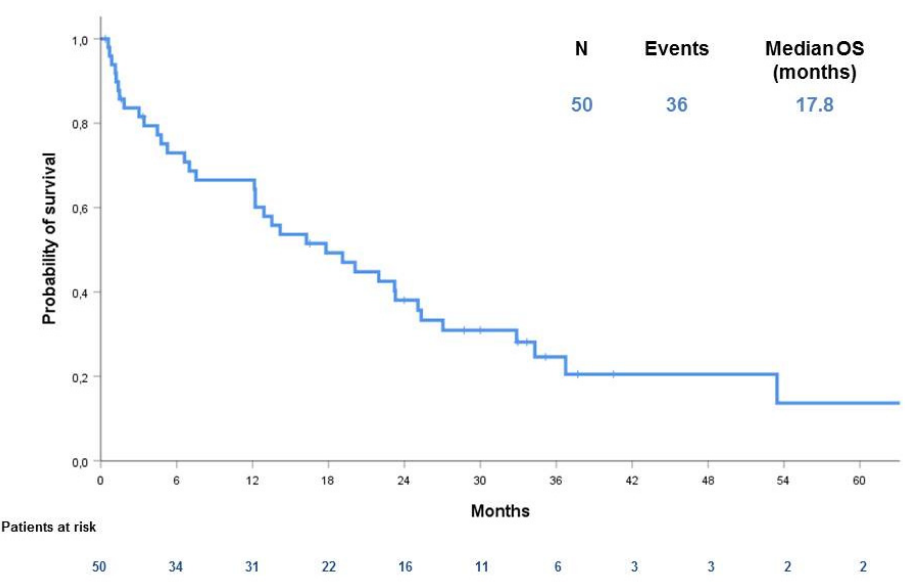
Figure 1. Overall survival (OS) in our case series.